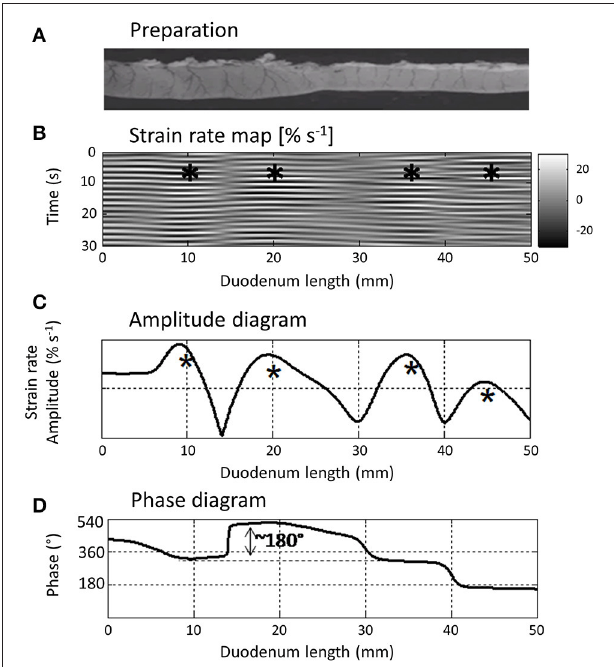
FIGURE 5 | L type ST Map (B) showing temporal variation in longitudinal components of segmentative contractions in the proximal duodenum (A) of the rat with concomitant variation in amplitude (C) and phasic relationship (D) over successive contractions. The regular sequences of (white) short-lived (limited vertical thickness) rapidly propagating (near horizontal) longitudinal contractions and following (dark) short-lived dilatation recur at similar sites along the duodenum and form a series of columns of varying length on the L map. The asterisks show the regions in which contractions tend to recurrently peak within each column which the authors term “domains” and the phase diagram the temporal relationship between the cyclic longitudinal contractions within each domain. Hence for example, the peak in amplitude (expressed as a percentage increase in the minimum strain in that domain) of the first marked column occurs during relaxation in the second marked column i.e., is 180 ◦ out of phase with the second. Figure adapted from Lentle et al.